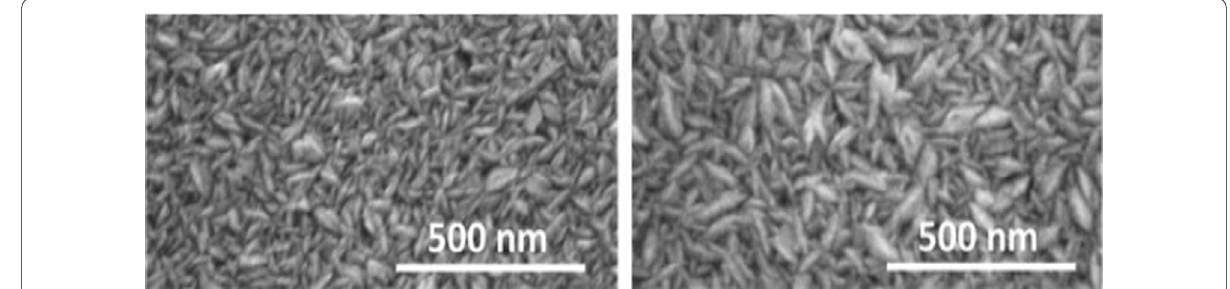
Fig. 16 SEM images of ZnO films deposited on Si using ALD and CVD